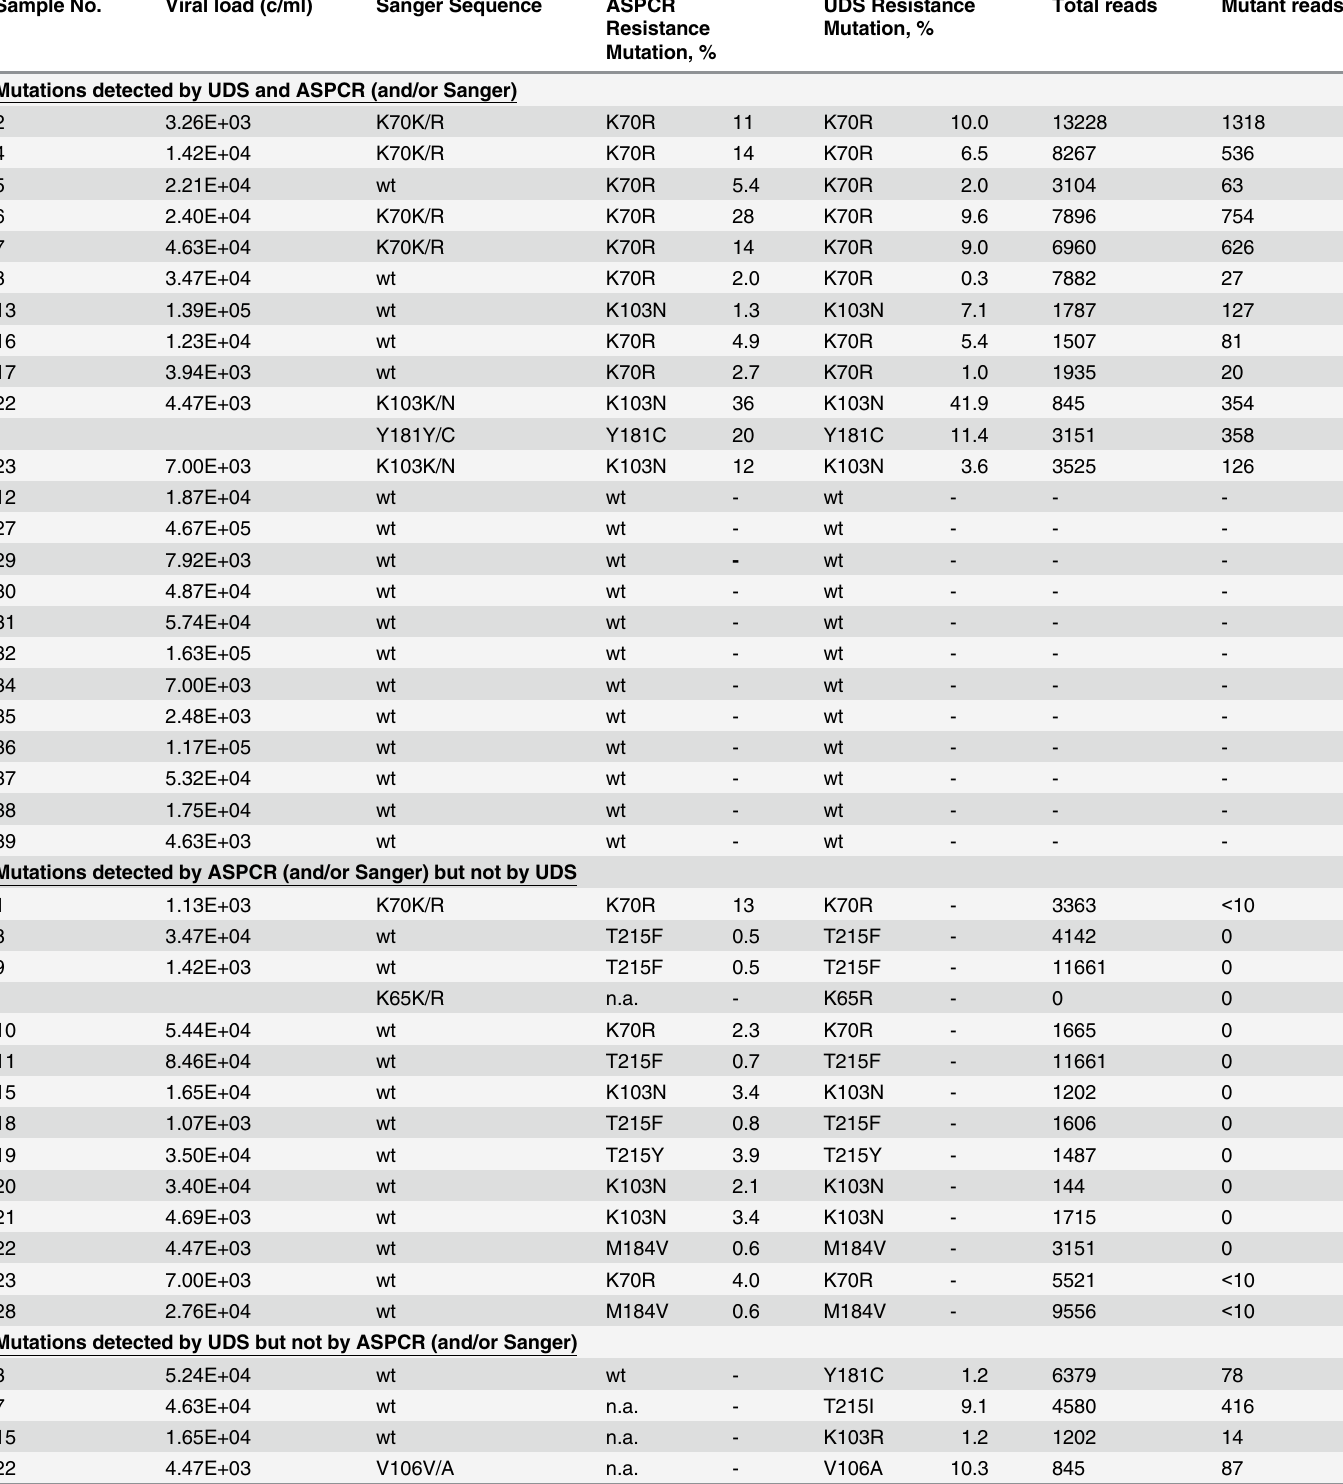
Table 3. Comparison of UDS, ASPCR, and Sanger sequencing. Sample